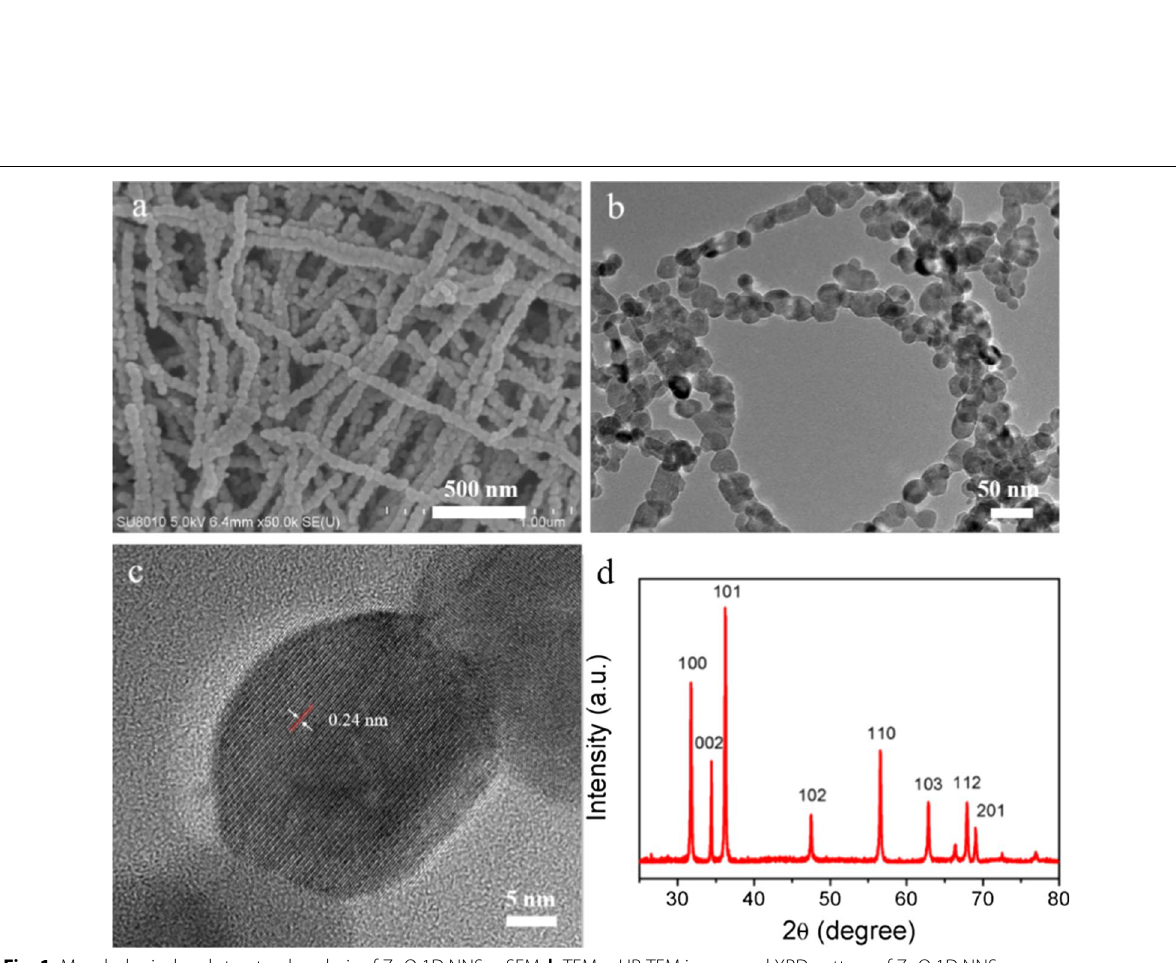
Fig. 1 Morphological and structural analysis of ZnO 1D NNS. a SEM, b TEM, c HR-TEM image and XRD pattern of ZnO 1D